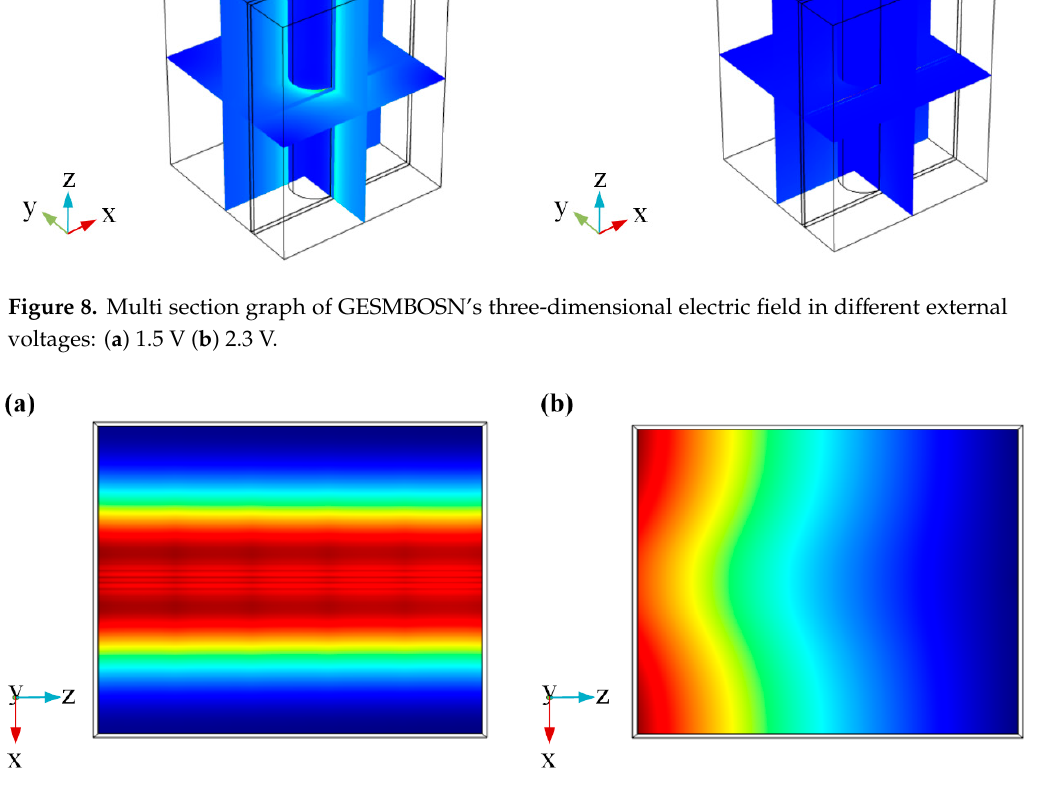
Figure 9. Electric field transmission cross section of GESMBOSN in different external voltages: ( a ) 1.5 V ( b ) 2.3 V.